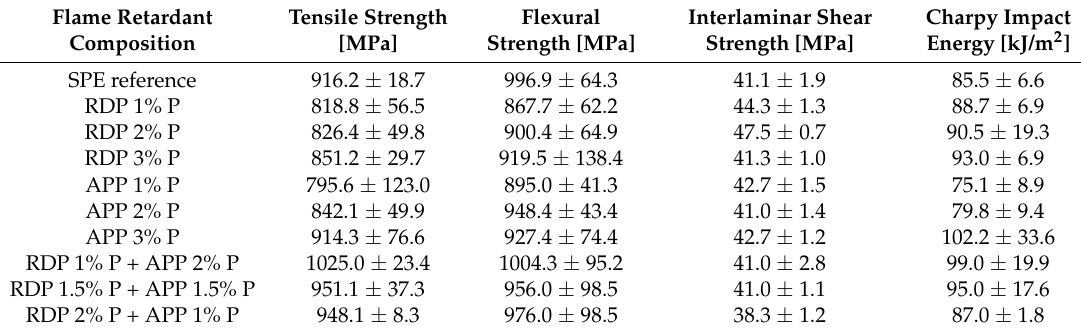
Table 5. Tensile, flexural, interlaminar shear, and Charpy impact properties of reference and flame retarded SPE